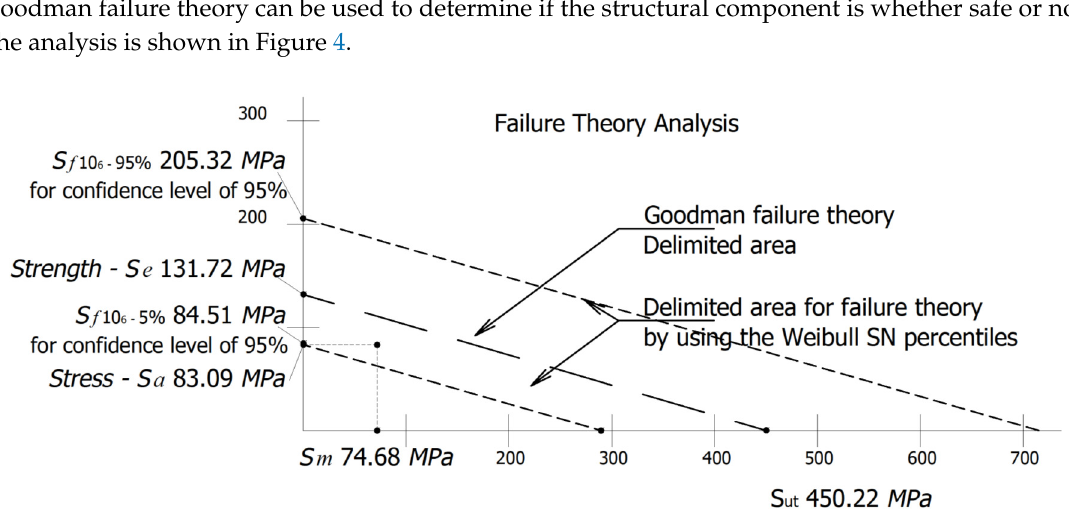
Figure 4. Goodman failure theory analysis.